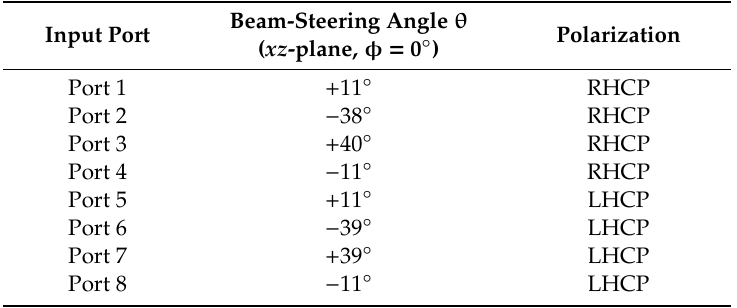
Table 2. Phases associated with the selected port of the 8 × 8 Butler matrix.